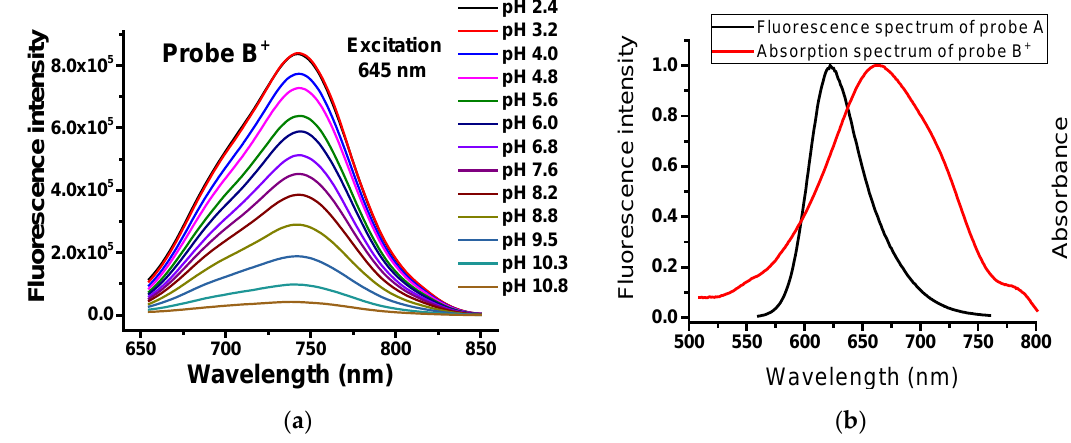
Figure 3. Fluorescence spectra of cyanine acceptor of probe B + in different pH buffers ( a ) , fluorescence spectrum of probe A, and absorption spectrum of probe B + at pH 4.8 ( b ) .